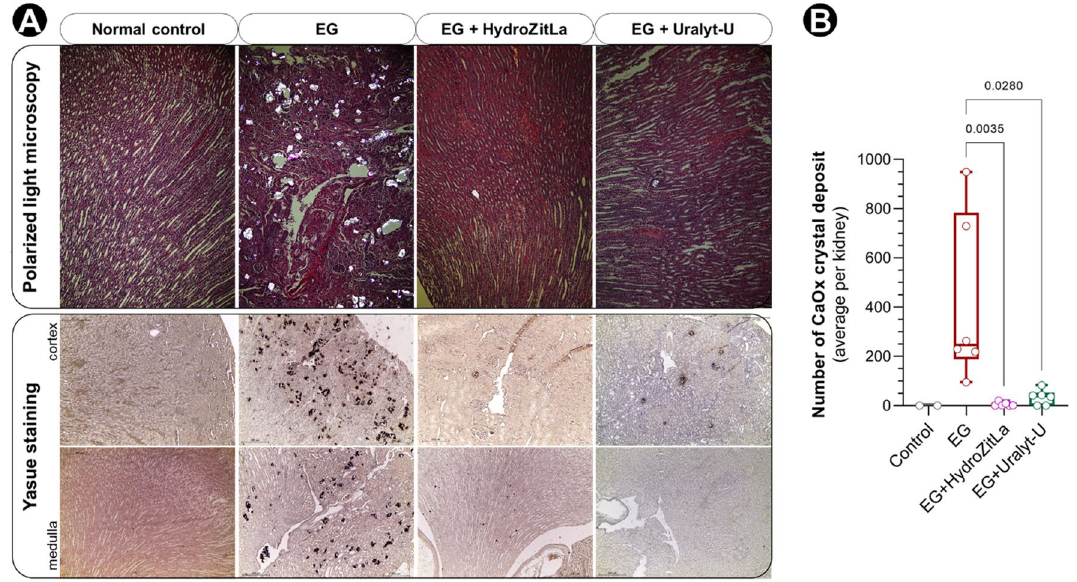
Figure 3. CaOx crystal deposits in rat renal sections detected by polarized light microscopy and Yasue staining. ( A ) The birefringent CaOx crystals were obviously accumulated in the renal sections of EG rats (upper panel). By contrast, the birefringent CaOx deposits were apparently vanished in the kidneys of EG + HydroZitLa and EG + Uralyt-U rats. Yasue staining confirmed that CaOx deposits were substantially deposited in EG rats’ kidneys, but they almost disappeared in kidneys of EG + HydroZitLa and EG + Uralyt-U rats (lower panel). These CaOx deposits were not observed in normal control rats. ( B ) CaOx deposits were counted in Yasue- stained sections. Numbers of intrarenal CaOx deposits in EG + HydroZitLa and EG + Uralyt-U rats were significantly lower than in EG rats. Micrograph magnification: ×